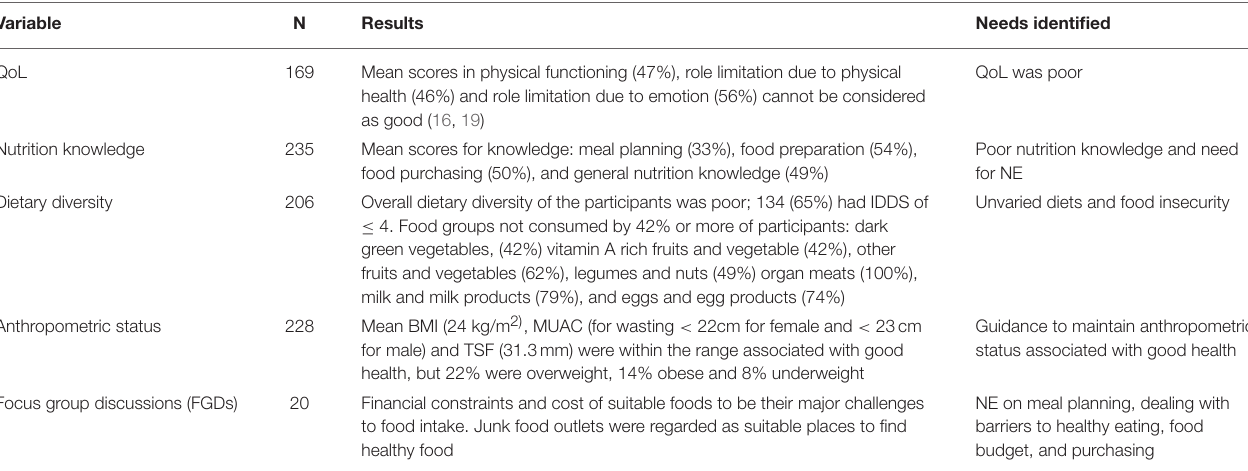
TABLE 1 | Summary of participants’ needs identified from the needs